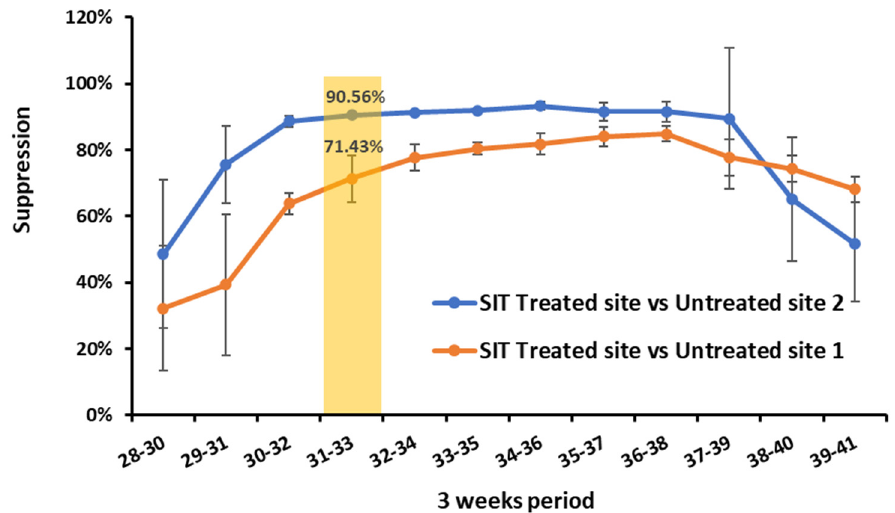
Figure 6. Suppression (%) of wild female D. suzukii population at the SIT-treated site compared to the two untreated control sites. Suppression is derived from the three-week moving averages of female D. suzukii per red sticky trap, comparing the SIT-treated site and the untreated control sites (suppression = 1- (treated site/control site)). The solid yellow box highlights the highest suppression rate achieved at the SIT-treated site in comparison to control sites prior to the insecticide spray at the SIT-treated site. Error bars represent the SE of the three-week